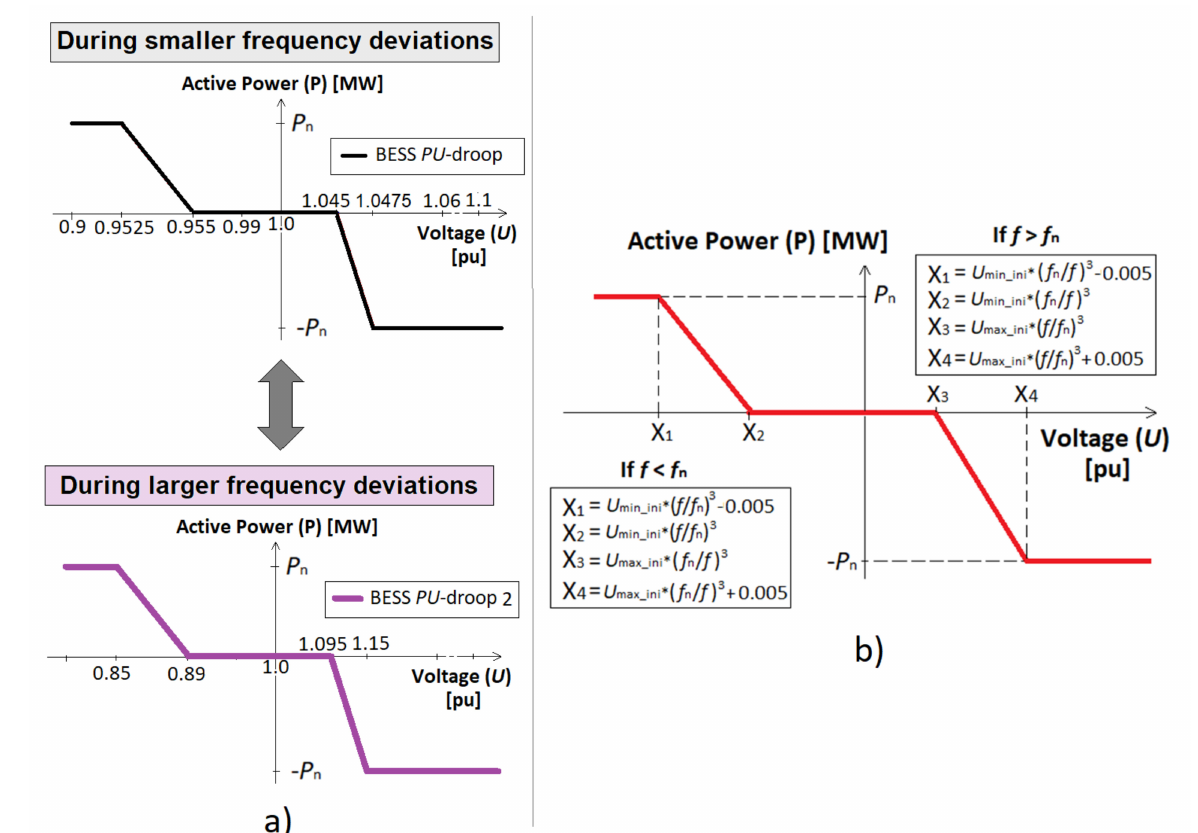
Figure 6. ( a ) Frequency adaptive DER unit PU -droop for a BESS during smaller and larger under and over-frequency situations and ( b ) Real-time smooth-frequency adaptive PU -droop without specific frequency and voltage limits for activation, e.g., for BESS unit [79] (see Tables 3 and